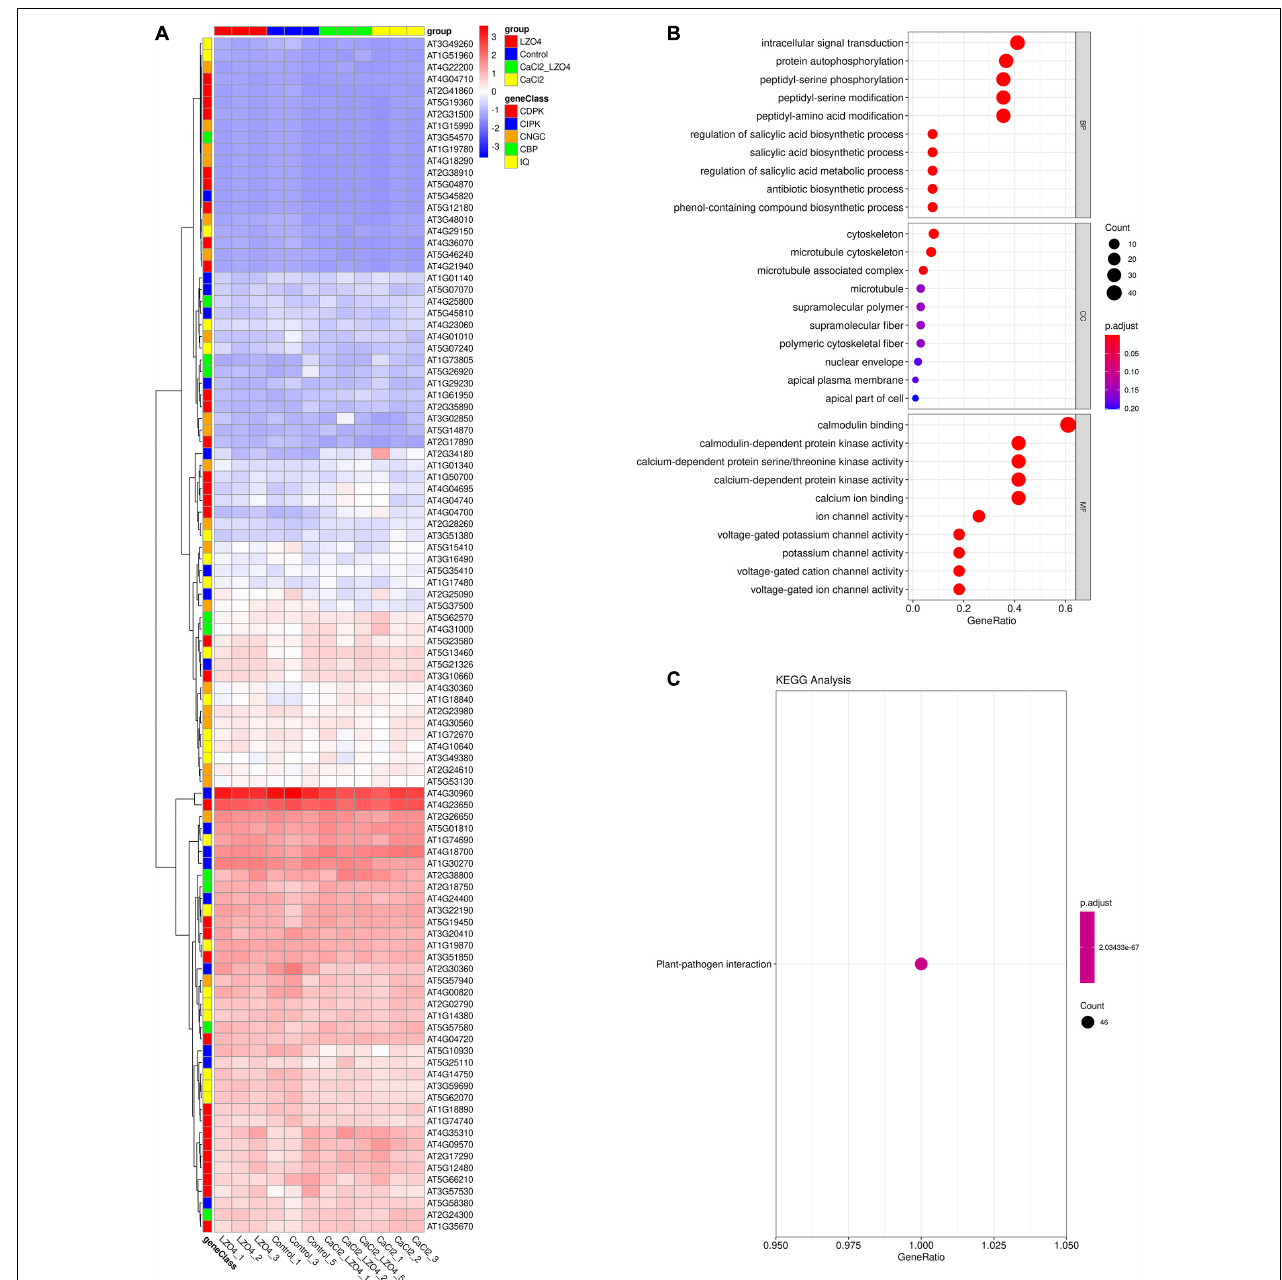
FIGURE 8 | Expression profiles and functional enrichment analysis of genes in calcium-related gene families in the roots of A. thaliana . (A) The expression profiles of the 102 genes in calcium-related gene families in the whole root of A. thaliana were shown in a heatmap. (B) The biological function (BP), cellular component (CC), and molecular function (MF) of the 102 genes in calcium-related gene families. (C) The KEGG pathways of the 102 genes in calcium-related gene families. The top 10 terms of the GO and KEGG (sorted by p .ajd.value) were selected for visualization. The size and color of the dots were related to the number of genes and the p.adj.value ,